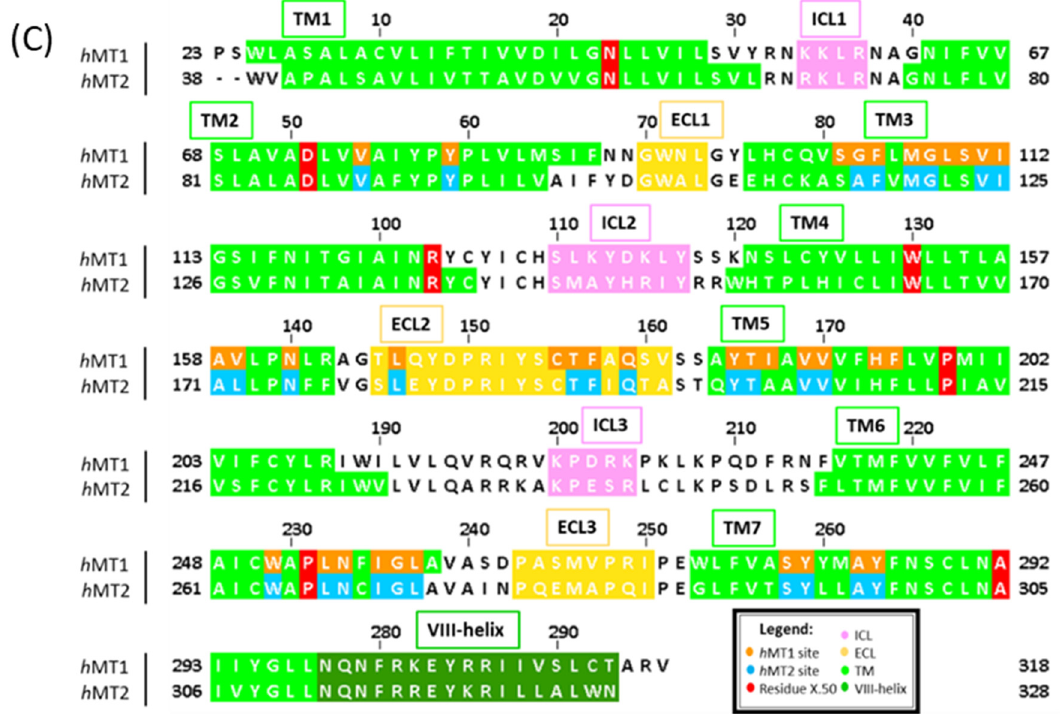
Figure 2. Snake plots reached by GPCRdb of the h MTs membrane topology, namely ( A ) h MT1 and ( B ) h MT2. Each TM has its own X.50 residues (red), references for Ballesteros–Weinstein numeration, and amino acids of the membrane (light green), repositioning the proteins with OPM sever. Also present are ICL (pink), ECL (yellow), and VIII-helix (dark green). The ligand (melatonin) is reported in green sticks. ( C ) The alignment shows the topology of the residues of the orthosteric sites of h MTs. Additionally, the snake graphs illustrate the residue distribution on the protein domains,